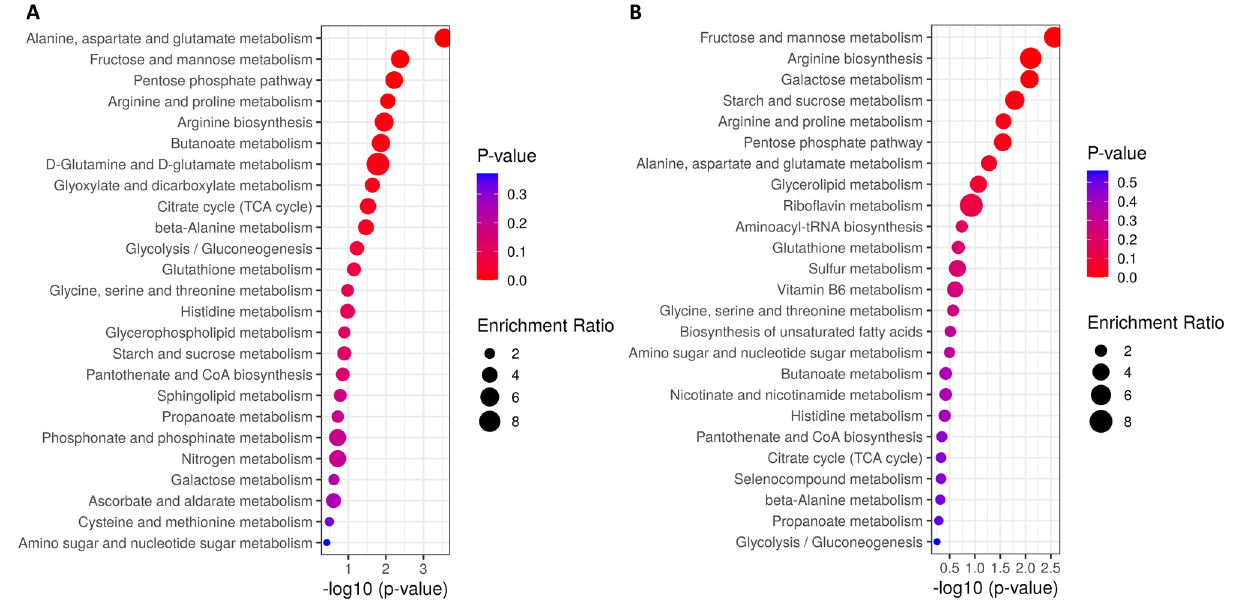
Figure 3. Metabolite Set Enrichment Analysis results from the analysis of metabolites mapped in KEGG human metabolic pathways and significantly altered (after Mann–Whitney U test with FDR < 0.05) in cell extracts ( A ) and extracellular medium ( B ) after incubation of HK-2 cells in HG (25 mM glucose)-hypoxia (1% O 2 ) compared to control (5.5 mM glucose/18.6% O 2 ) conditions for 48